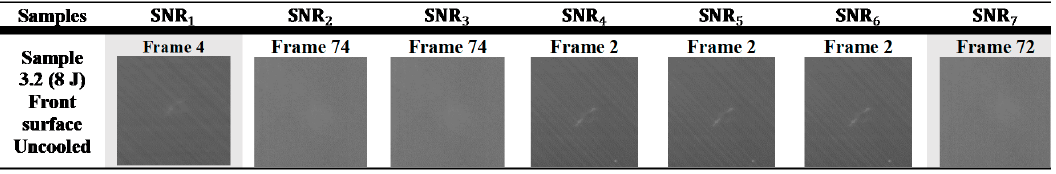
Figure 18. The SNRs for 3.2frontuncooled originally failed to locate the defect; however, after TSR, SNR 4,5,6 successfully located the defect.